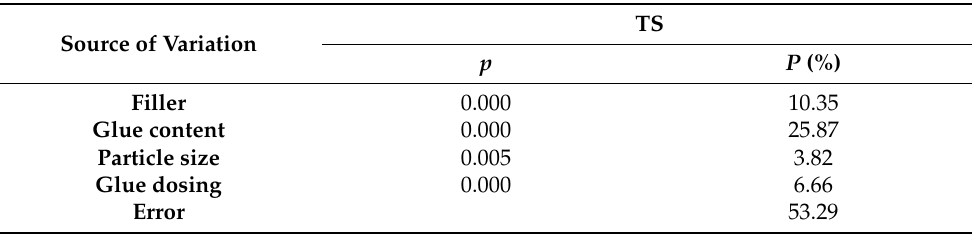
ANOVA for selected factors affecting the TS of the manufactured particleboards ( p = probability of non-significant effects, P = percentage